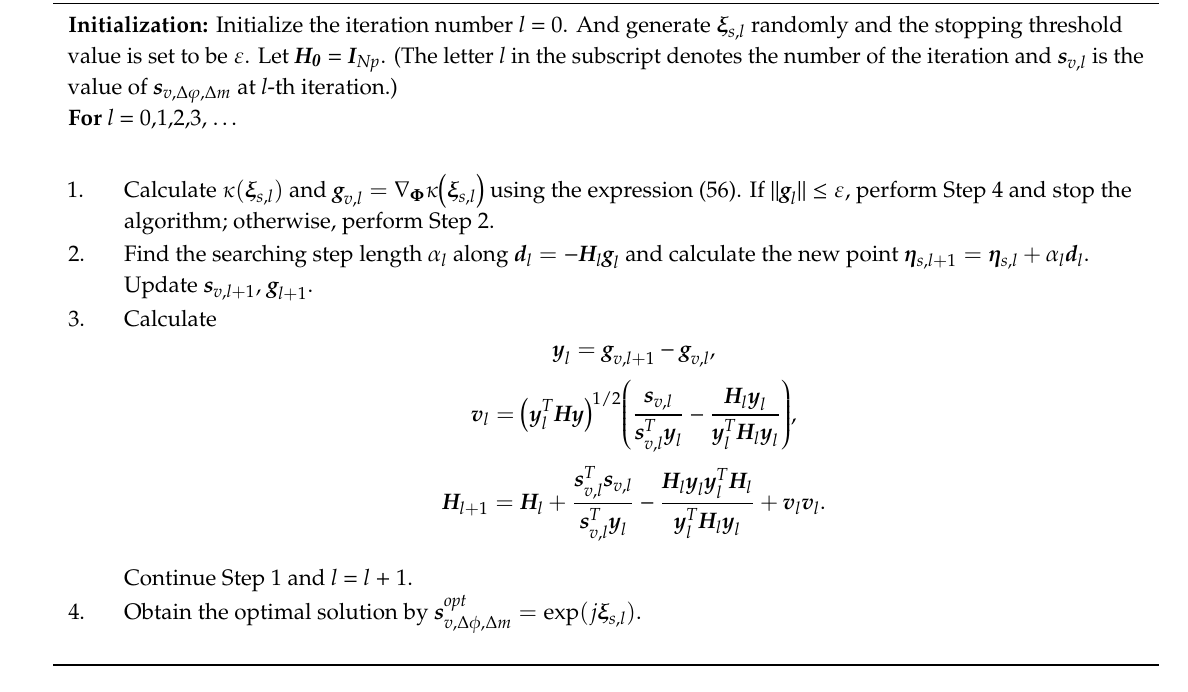
Algorithm 1: Solving the problem (40) with